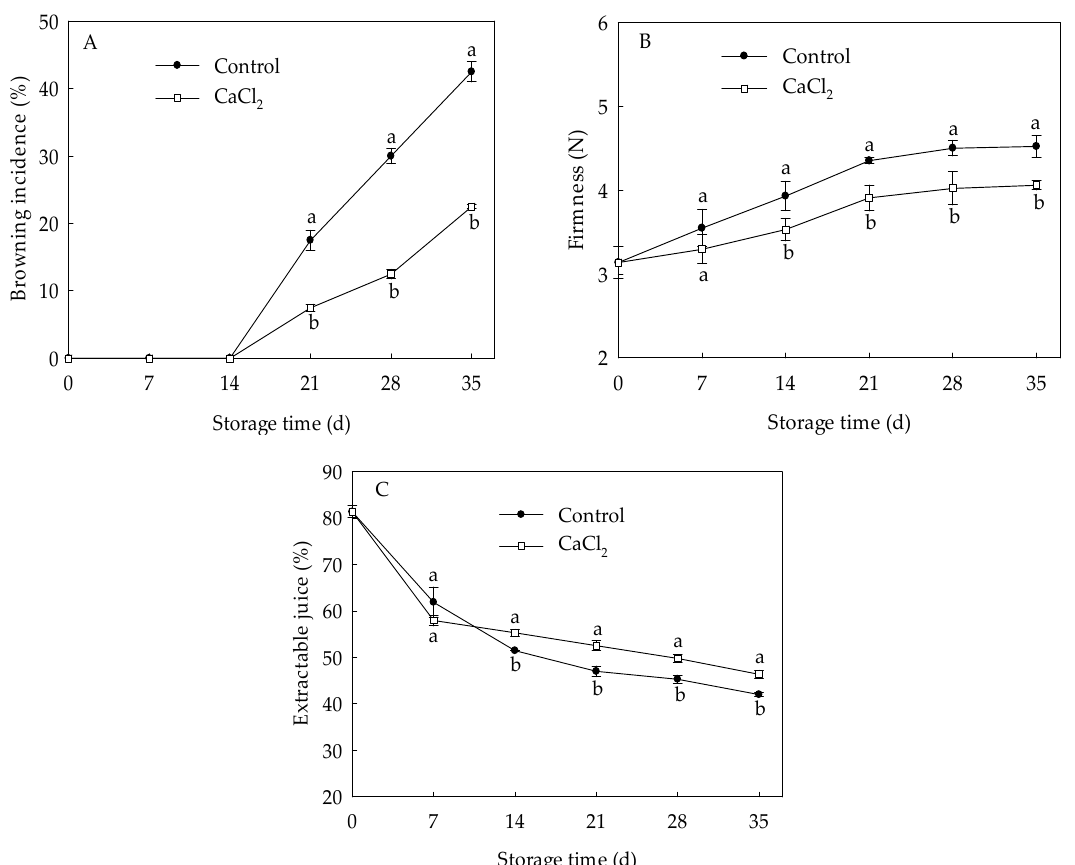
Figure 1. Browning index ( A ), firmness ( B ), and extractable juice ( C ) in loquat fruit stored at 1 °C after treatment with 1% CaCl 2 or water (control). Vertical bars indicate the SE of mean ( n = 3). The symbols a and b represent a significant difference in the two treatments ( p < 0.05).